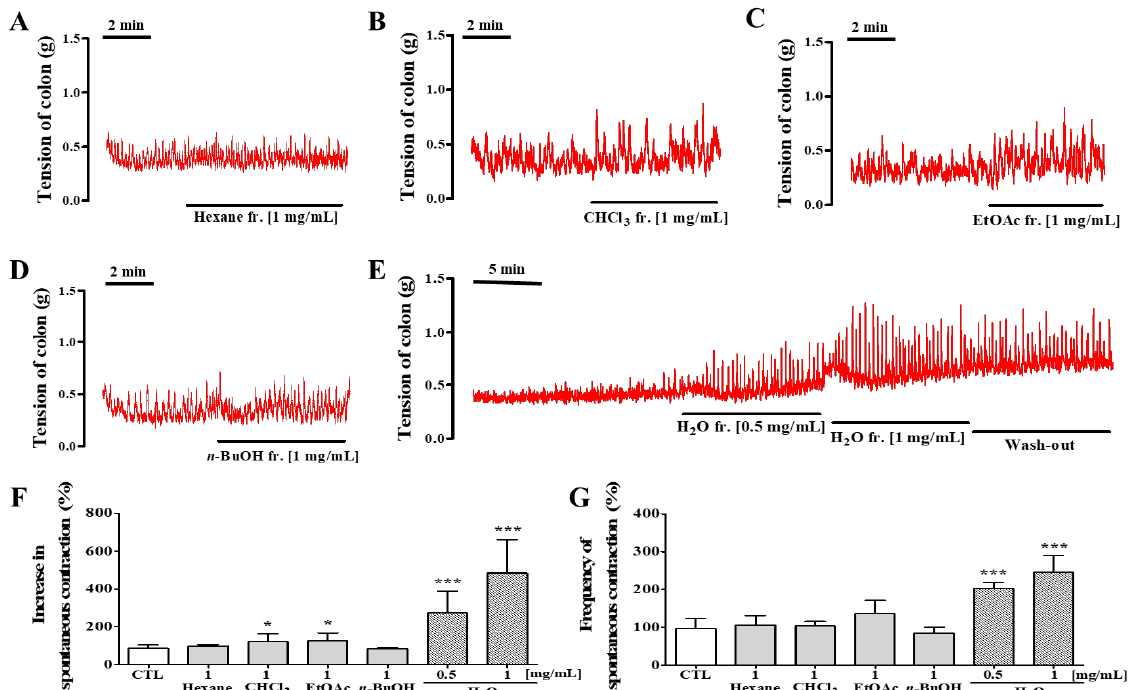
Figure 11. Physiological recordings of spontaneous contractions of the isolated rat colon showing the stimulatory effect of D. morbiferus H. Lév. leaf extract (DPL) fractions. The stimulatory effects of ( A ) 1 mg/mL 𝑛 -hexane fraction, ( B ) 1 mg/mL chloroform (CHCl 3 ) fraction, ( C ) 1 mg/mL ethyl acetate (EtOAc) fraction, ( D ) 1 mg/mL 𝑛 -butanol ( 𝑛 -BuOH) fraction, and ( E ) 0.5–1 mg/mL aqueous (H 2 O) fraction. The amplitude of contractions was calculated as the average over 1 min ( F ). The frequency of contraction was measured over 5 min ( G ). * Significant difference at p < 0.05 and *** at p < 0.001 compared with the baseline (control; CTL).